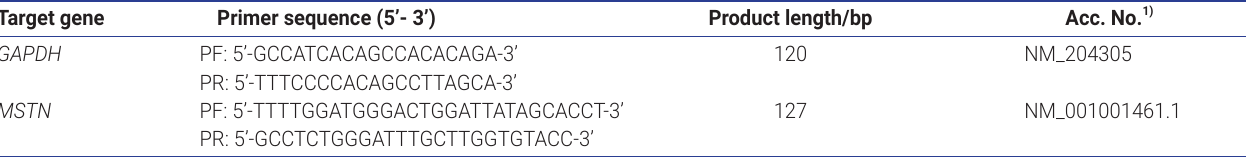
Table 3. Primer sequences and GenBank accession number for the target genes Target gene Primer sequence (5’-